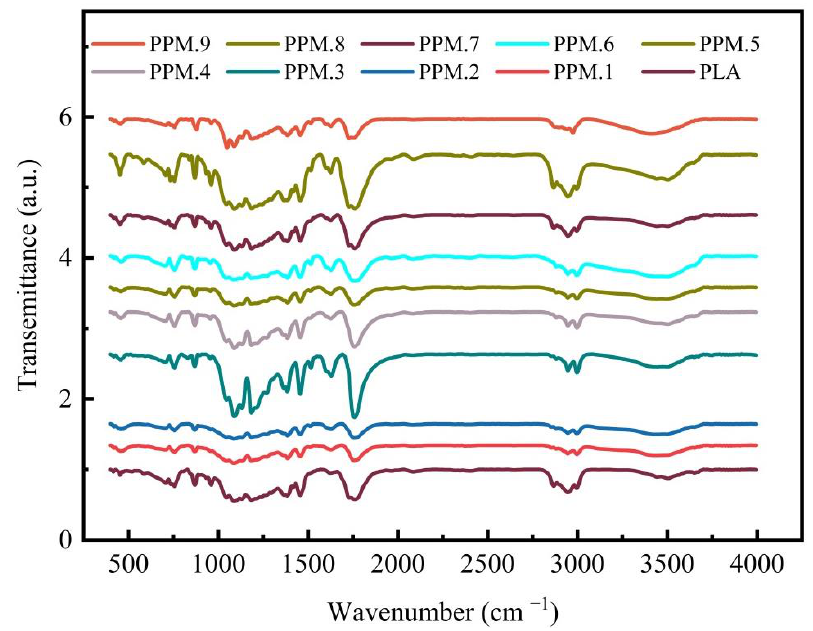
Figure 5. FTIR spectra of pure PLA and PLA films loaded with different amounts of the phlridzin/MCM-41 assembly .